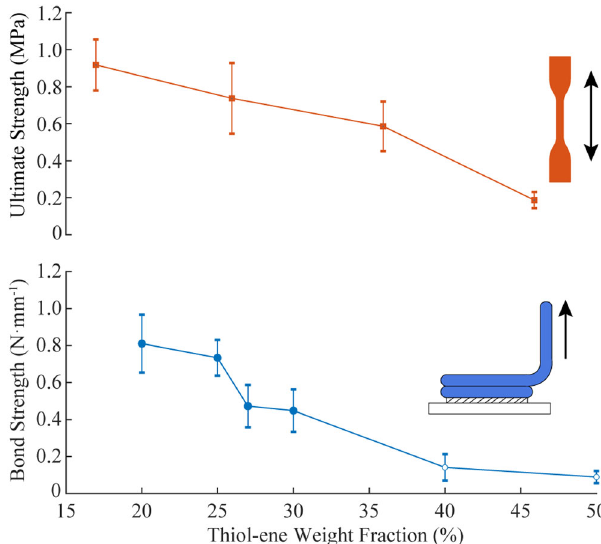
Fig. 3 Comparison of interlayer bond strength (3D printed samples) and ultimate strength (molded samples). Effect of thiol-ene weight fraction on bond strength between layers of the printed objects (blue color). Filled circle markers indicate cohesive failure and open circle markers indicate adhesive failure (Supplementary Fig. 3). Ultimate strength of the molded samples also presented as a comparison (orange color), data imported from reference. 27 Error bars represent one standard